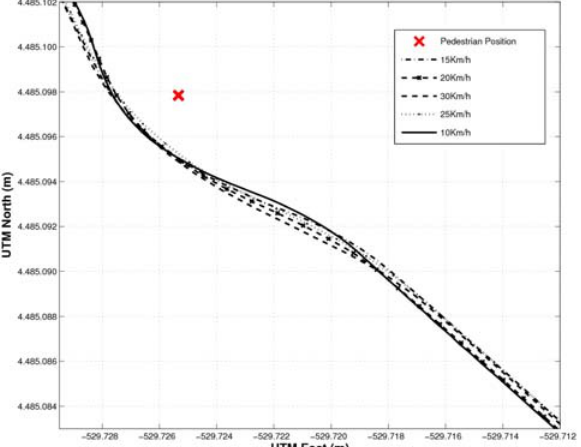
Figure 12. Pedestrian collision avoidance maneuvers at different